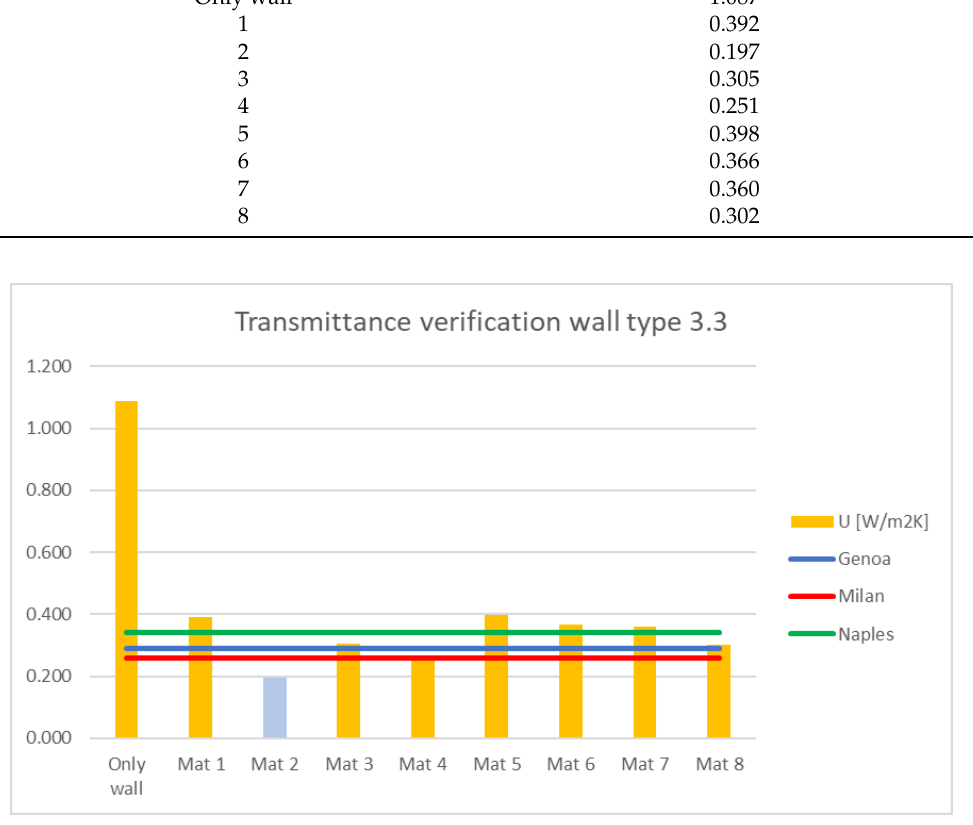
Figure A10. Wall type 3.3: transmittance check for the three main Italian climatic zones. In are blue the heat-reflective materials which respect all the limits.